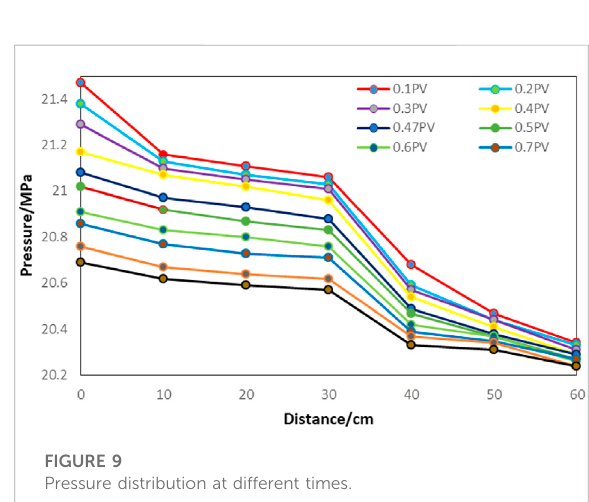
FIGURE 8 Comparison of the recovery degree of different fracture lengths.